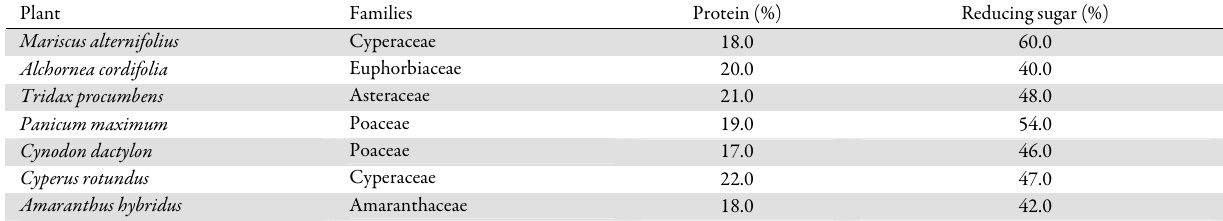
Table 4. Proximate analysis of some pollen